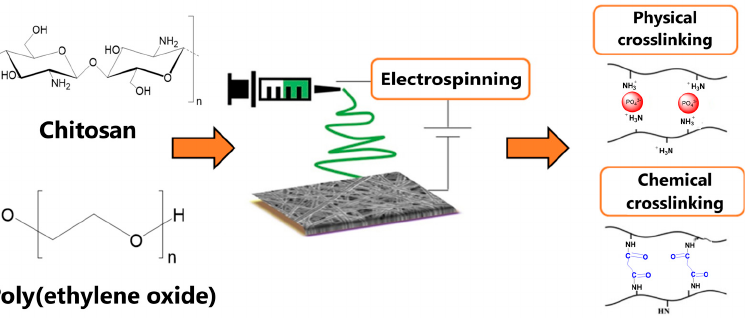
Figure 7. Fabrication of CS-based electrospun membranes. Reprinted from [109], Polymers